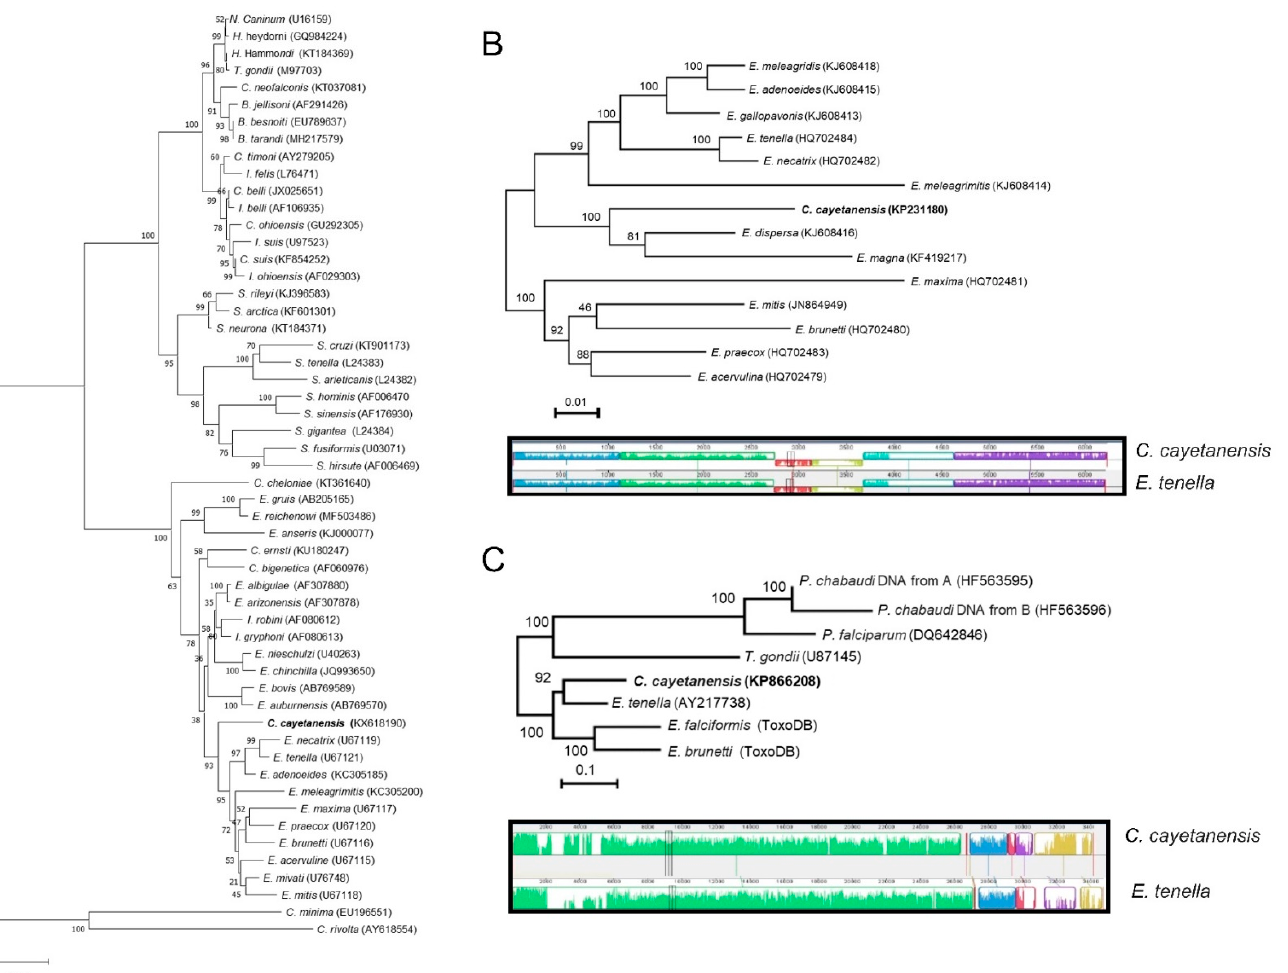
Figure 4. Phylogenetic relationship between C. cayetanensis and Eimeria species. Maximum likelihood phylogenetic tresses were constructed using ( A ) 18S rDNA, ( B ) mitochondrial genome, and ( C ) apicoplast genome. Synteny in genome organizations between Cyclospora cayetanensis and E. tenella is shown in the mitochondrial ( B ) and apicoplast ( C ) genomes. ( B , C ) were modified with permission from Refs. [30,34].